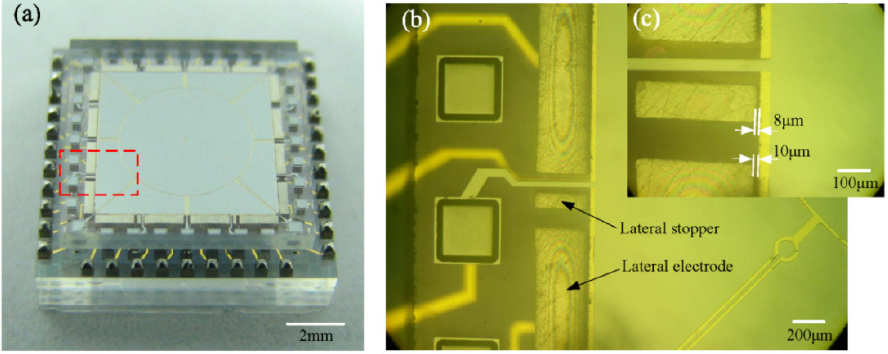
Figure 11. (a) Optical photograph of a solder bonded microaccelerometer chip about 10 × 10 × 3 mm 3 , where the pads are coated with solder bumps. (b) and (c) Microphotographs of the partly enlarged microaccelerometer chip, seen through the bonded top glass